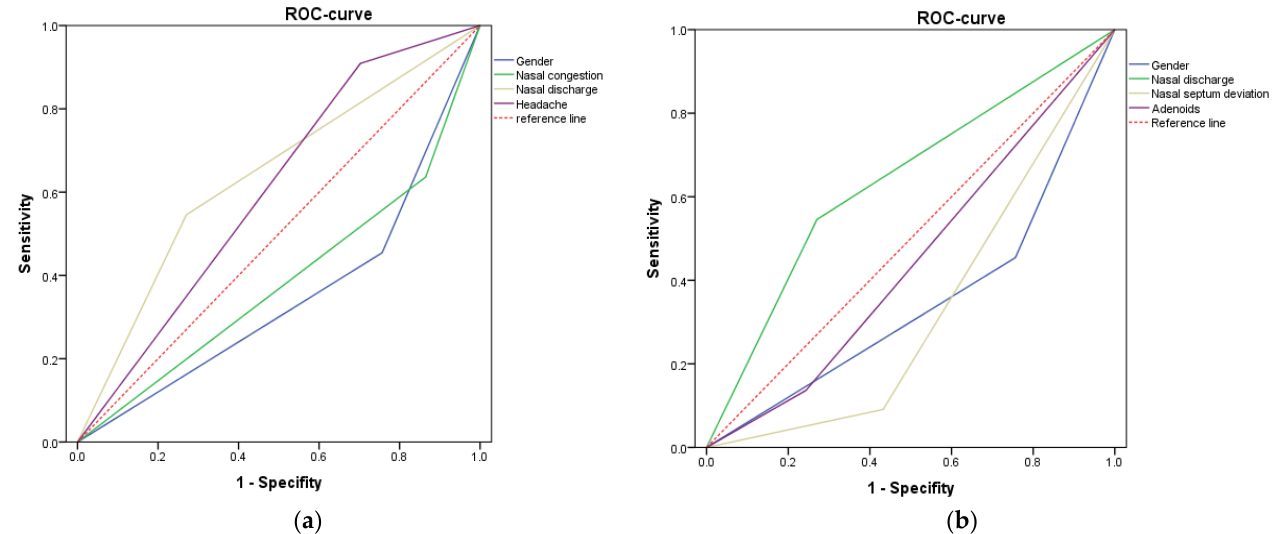
Figure 3. ROC curve for prediction of: ( a ) conservative treatment for complaints; ( b ) surgical therapy for complaints with pathology. Table 1. Values of single-marker detection for patients with medical therapy and surgical therapy. Anatomical